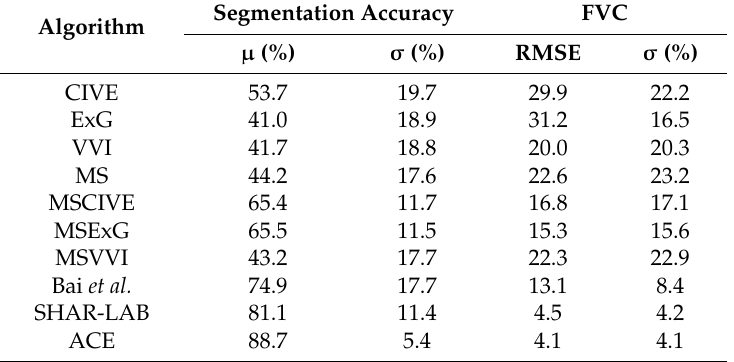
Table 3. Segmentation accuracy; RMSE and standard deviation of difference between estimated FVC values and the ground truth FVC values for the ten algorithms evaluated using a remotely sensed corn